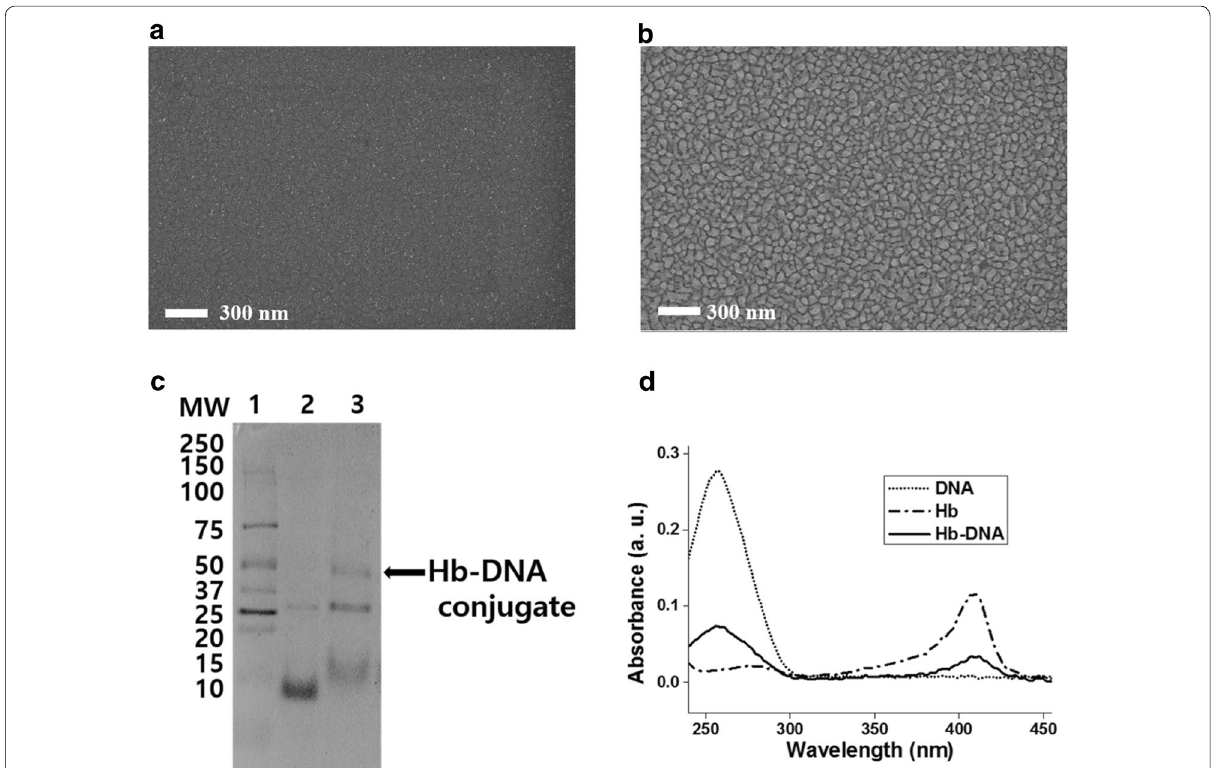
Fig. 2 SEM images of a bare gold; b NPGF electrode; c SDS‑PAGE (lane 1 for protein ladder, lane 2 for Hb, lane 3 for Hb‑DNA conjugate); d UV–VIS results of Hb‑DNA